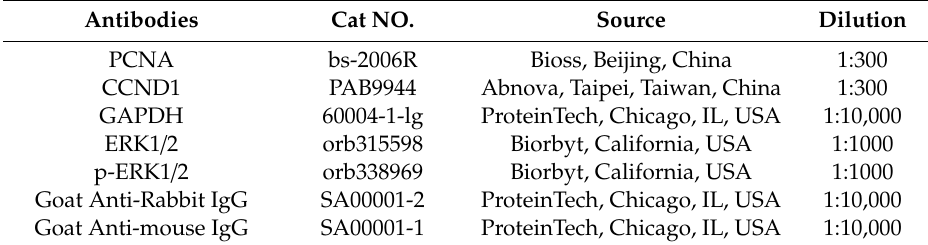
Table 4. The information of antibodies. Antibodies Cat